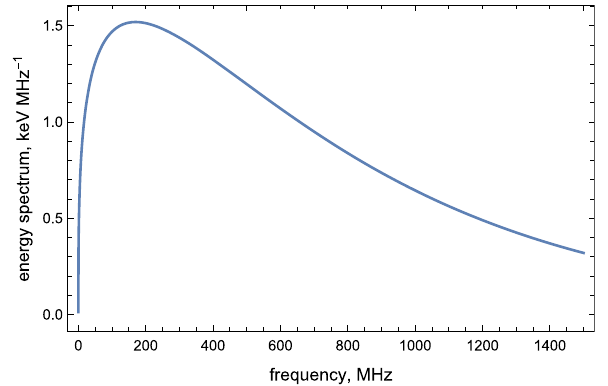
Fig. 5 Spectrum (32) in terms of frequency ν , geosynchrotron radia- tion.Theparametersarechosentobe N = 10 9 , γ = 20, B = 0 . 5gauss, θ B = π/